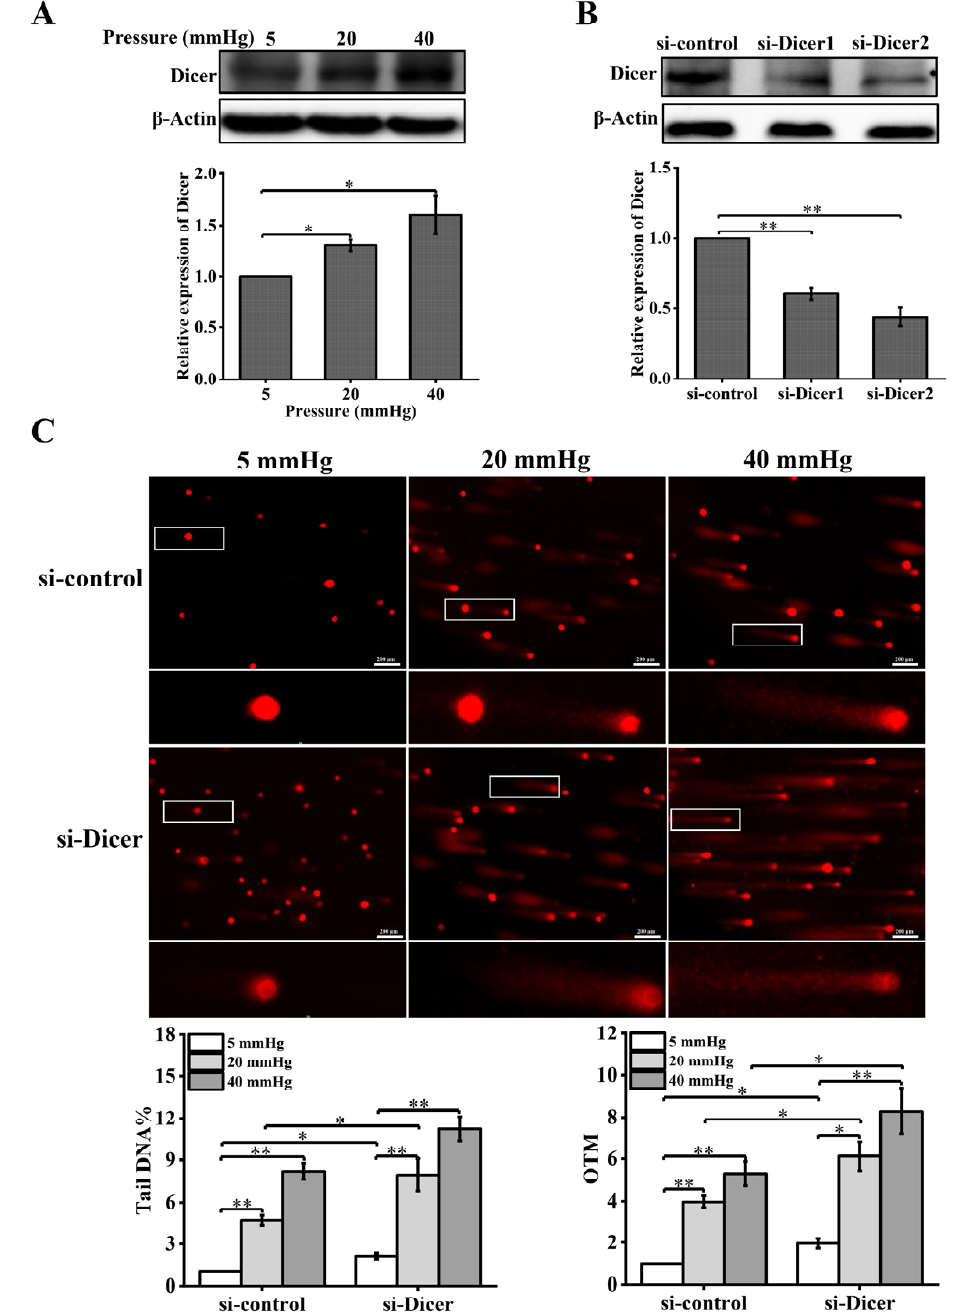
Figure 3. Reduced Dicer expression levels enhance pressure-induced DNA damage in hepatocytes: ( A ) hepatocytes were treated with different pressure levels (5, 20, 40 mmHg) for 48 h. Western blot analysis showed the protein level of Dicer; ( B ) the cells were transfected with negative control siRNA or Dicer siRNAs for 48 h. Western blot showed the protein level of Dicer after knockdown of Dicer; ( C ) DNA damage in hepatocytes cultured for 48 h under different pressure levels (5, 20, 40 mmHg) with Dicer knockdown was examined with the comet assay. OTM and tail DNA% were used to calculate the degree of DNA damage (scale bar, 200 µm). Data are expressed as the mean ± SD. n = 3, * p < 0.05, ** p < 0.01 .